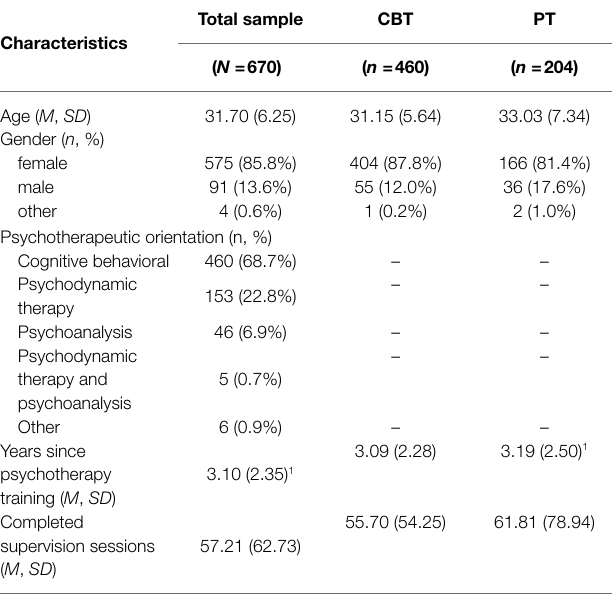
TABLE 1 | Characteristics of the total sample and separated according to trainees with cognitive behavioral orientation (CBT) and psychodynamic/ psychoanalytic orientation